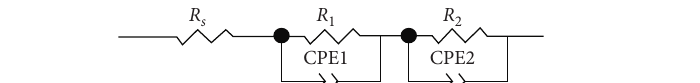
Figure 7: Equivalent circuit used to fit experimental data of the impedance spectrum at different time periods.